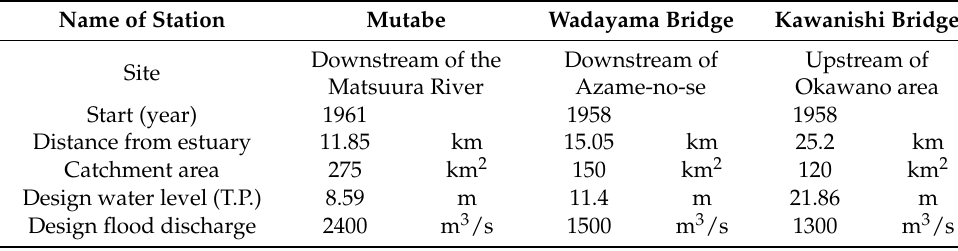
Distance from estuary Design water level (T.P.)